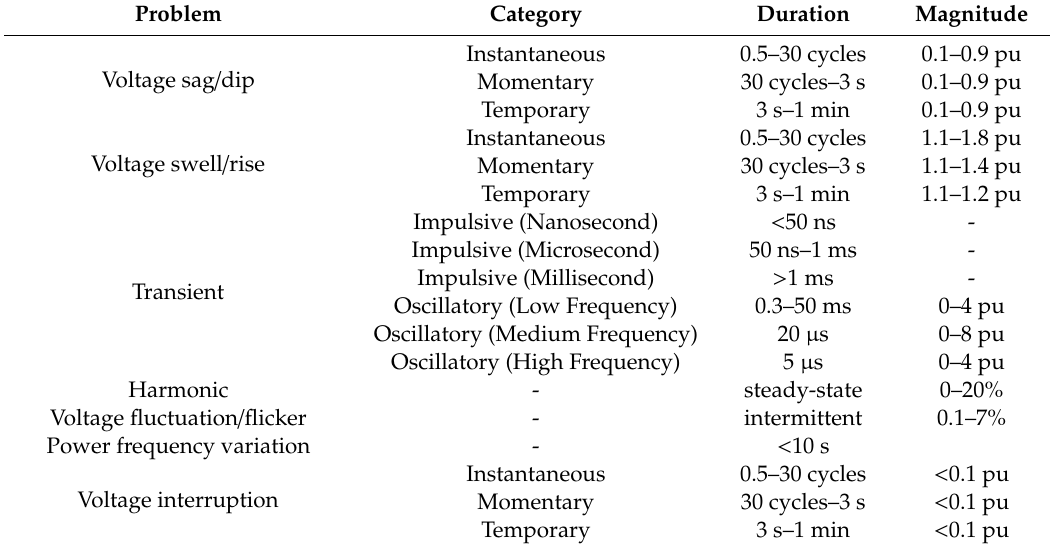
Table 3. Duration and magnitude of power quality issues. Based on data from [20–29].